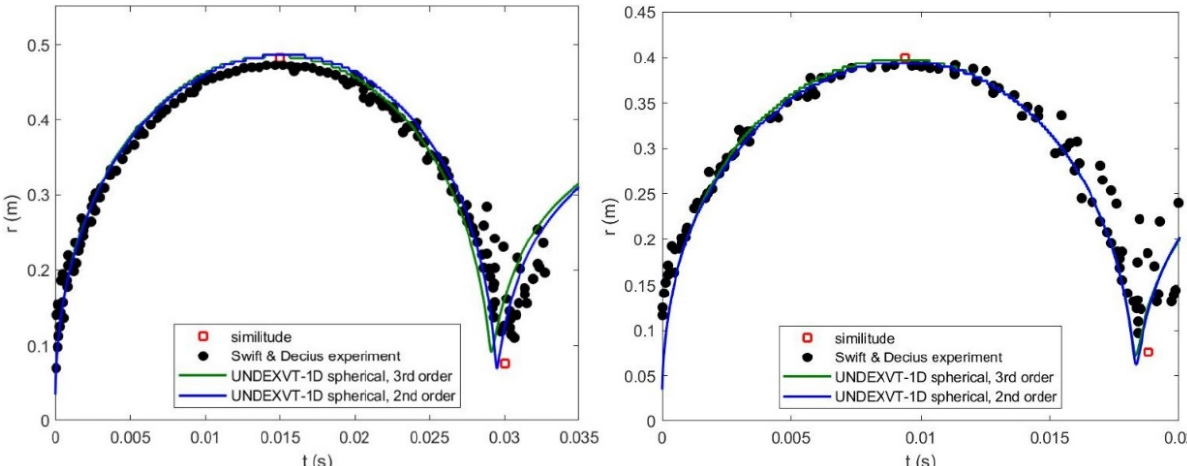
Figure 21. Variation of the bubble radius over time, for 0.66 lb TNT exploding 300 ft and 550 ft below the surface (from left to right ).